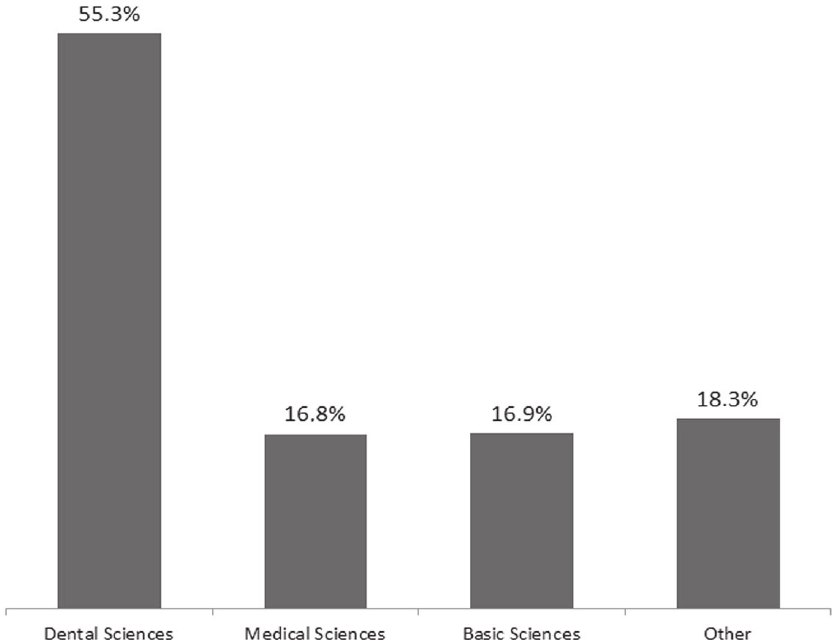
Figure 1- Distribution of scientific works available in CAPES Theses Database according to field of knowledge from 2001